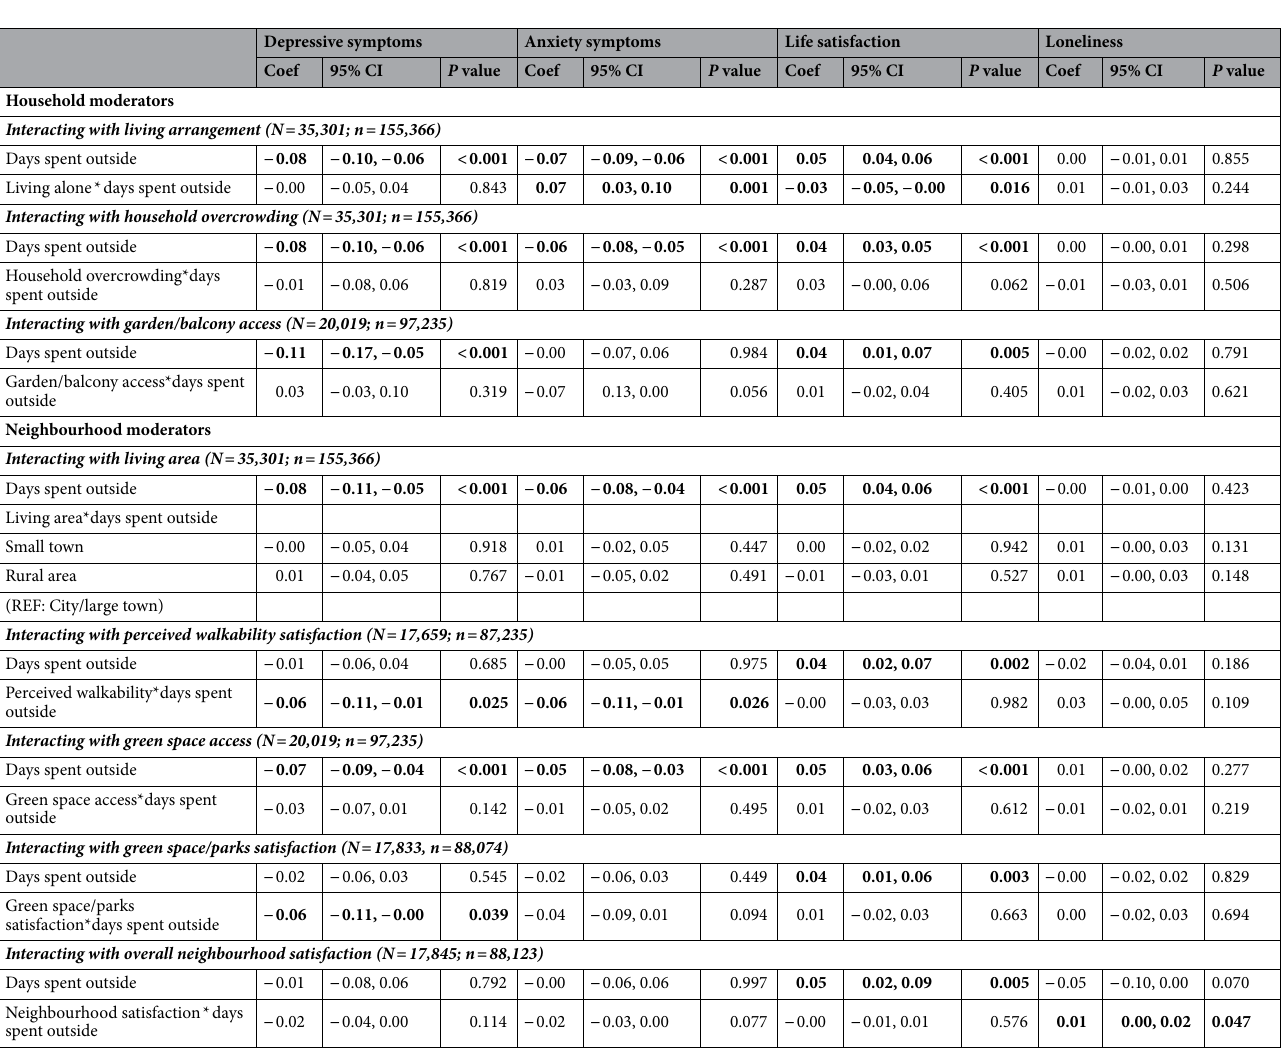
Table 3. Fixed-effects models estimating the associations between days spent outside and mental health and mental wellbeing: the moderating effects of household and neighbourhood factors. The models controlled for all time-invariant variables and time-varying variables including number of days respondents have had face to face contact with others for ≥ 15 min in the past 7 days, number of days respondents have had phone/video call with others for ≥ 15 min in the past 7 days, perceived social support, compliance with the government isolation guidance, and self-isolation status. Significant values are in